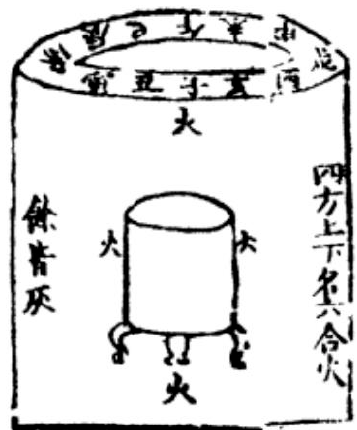
Figure 15. The cabinet of the fountain and the iron rack with three legs (Zhao 1988, p.